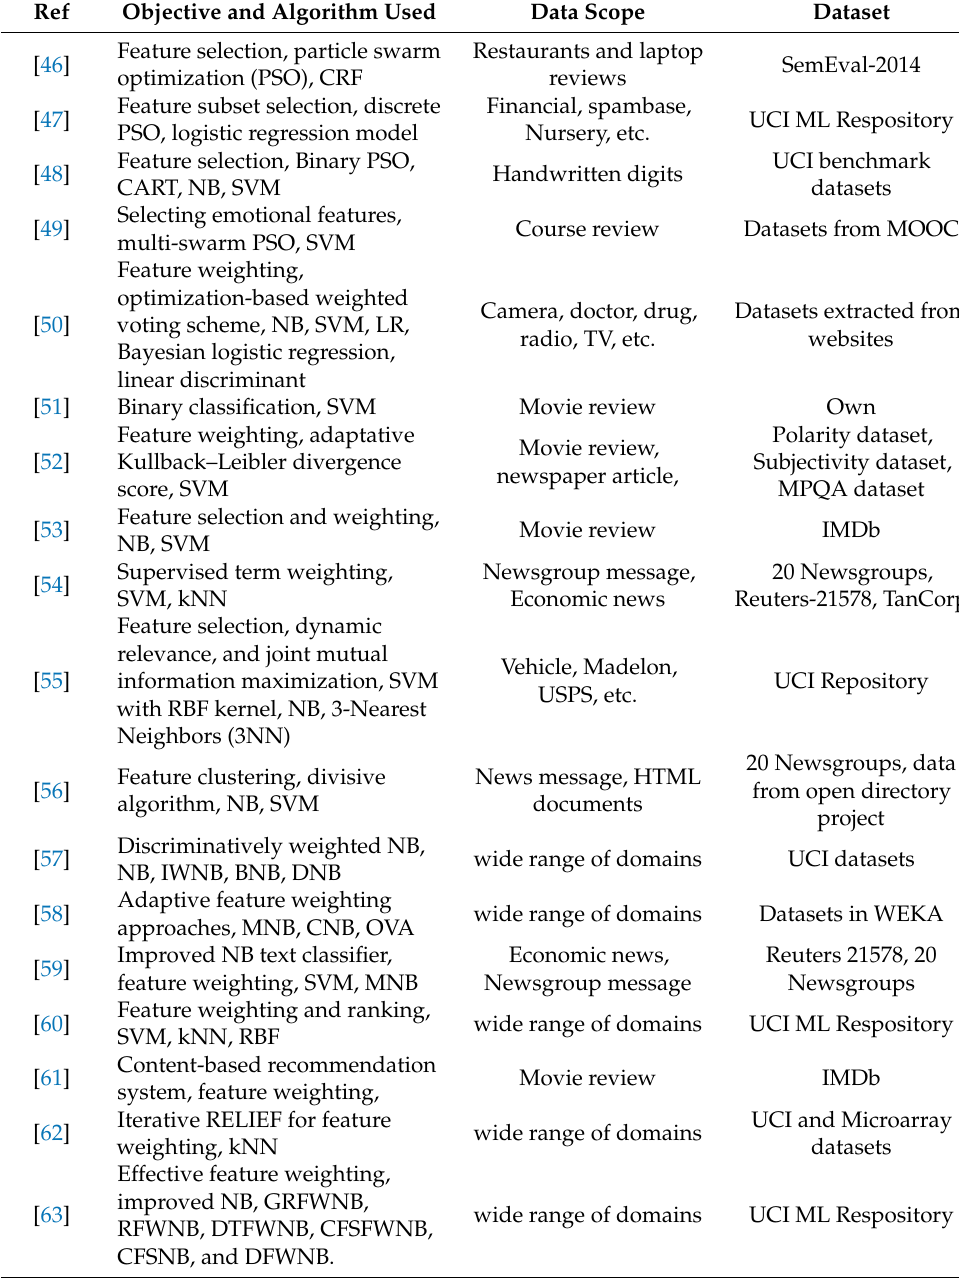
Table 4. The list of machine learning-based approaches for sentiment